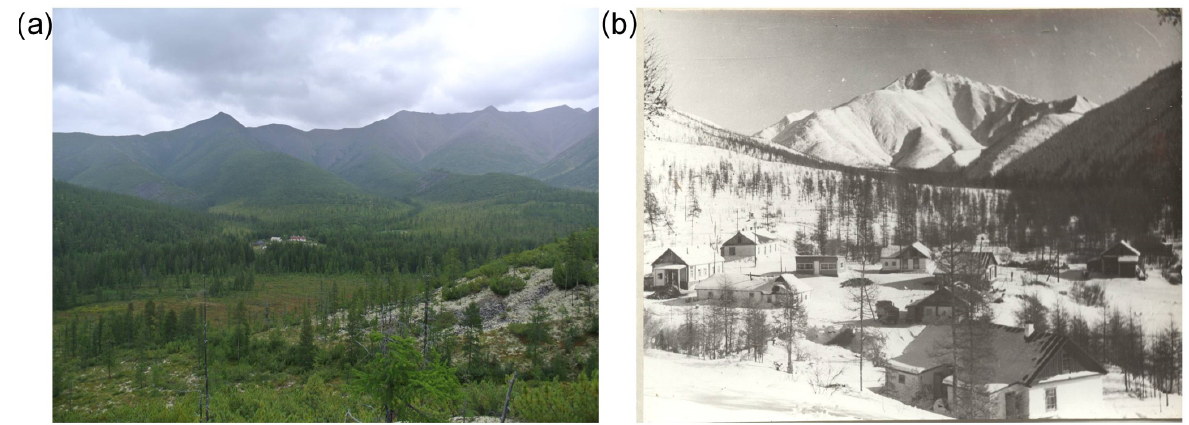
Figure 1. View of the Kolyma Water-Balance Station in (a) August 2016 (photo by O. Makarieva), and (b) historical photo from Sushan- sky